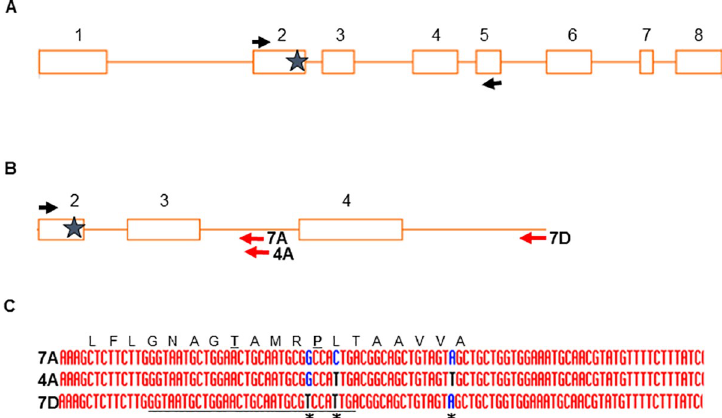
Fig 1. Overview of wheat EPSPS homoeolog cloning and TILLING strategy and homoeolog-specific SNPS. A. The genomic intron-exon structure of the rice EPSPS is shown. Boxes indicate the eight exons and lines represent introns. The black arrows indicate the locations of PCR primers used to amplify fragments of wheat EPSPS homoeologs from wheat genomic DNA spanning the active site of the enzyme-indicated with a star. B. TILLING of EPSPS homoeologs was accomplished with a common left primer (black arrow) and homoeolog-specific right primers (red arrows). C. Alignment of the active site regions of wheat EPSPS homoeologs showing homoeolog-distinguishing SNPs-indicated by asterisks. Key active site residues threonine and proline are underlined. Alignment created using default parameters of the software: Multalin